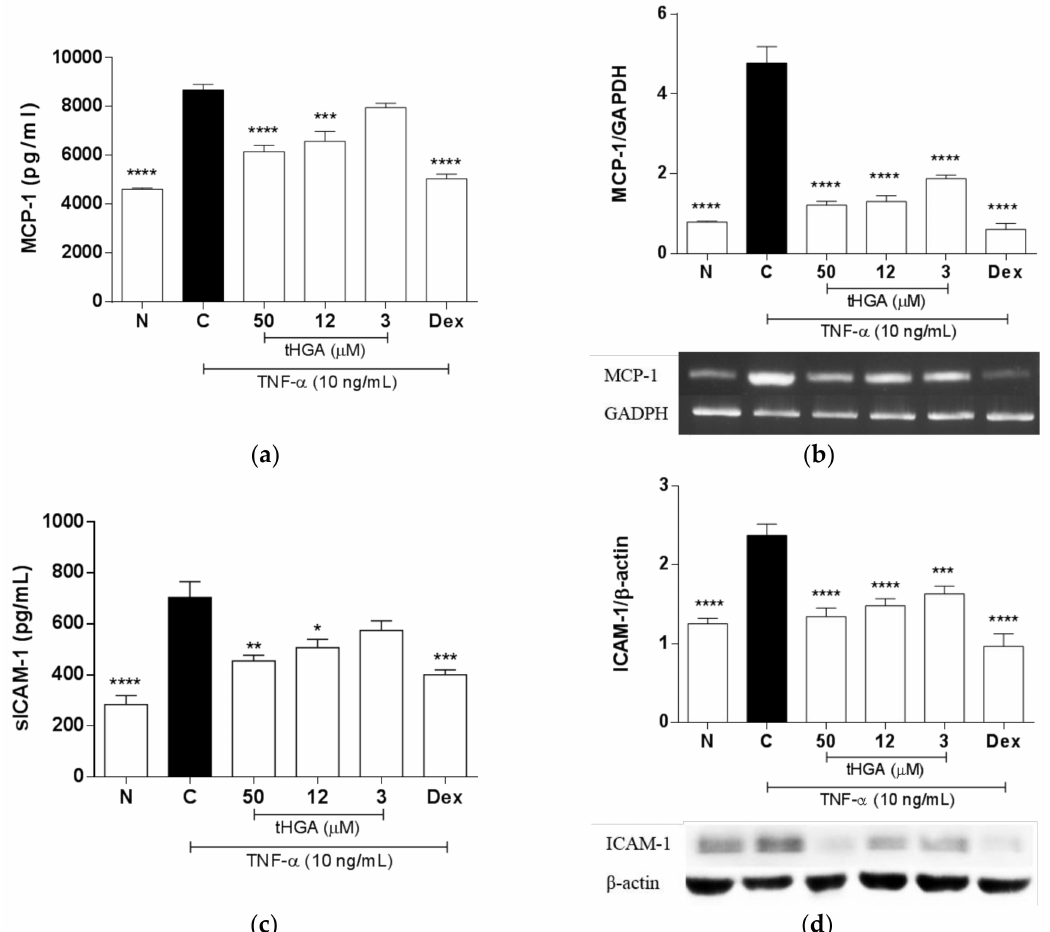
Figure 3. The effects of tHGA on the production of key pro-inflammatory mediators by A549 cells following TNF- α induction. ( a ) The concentration of soluble MCP-1 in A549 cell culture supernatant and ( b ) MCP-1 gene expression in A549 cells following TNF- α induction. ( c ) The concentration of soluble ICAM-1 in A549 cell culture supernatant and ( d ) ICAM-1 protein expression in A549 cells following TNF- α induction. A549 cells were stimulated with 10 ng/mL TNF- α and treated with increasing concentrations of tHGA and positive control for 24 h. The levels of secreted pro-inflammatory mediators were determined by ELISA, as described in Methods. For gene or protein expression